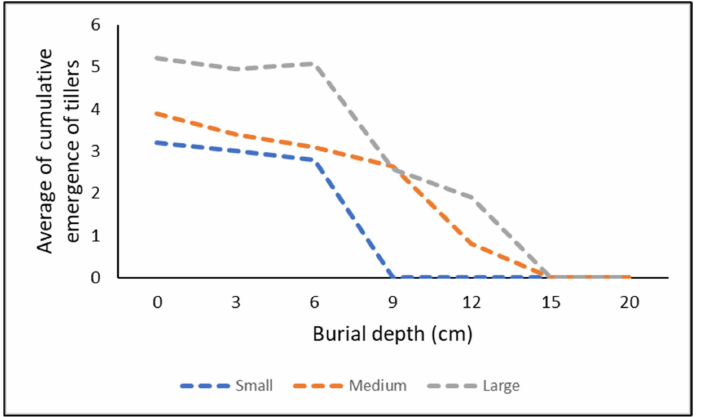
Figure 1. Average of cumulative emergence of tillers from buried Cyperus aromaticus rhizome frag- ments of different sizes over a period of 70 days. Emergence was averaged for both the soil types used.